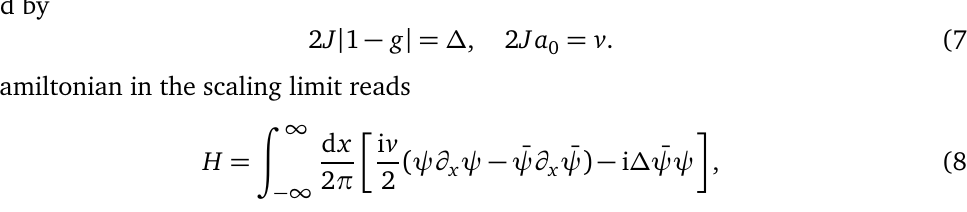
Figure 11: Left: Rate function of the return probability following linear quenches of different durations. We stress that the first critical time t (cid:63) time axis we indicate the quench durations τ = 1 is crossed. Right: Scaling of the critical momenta defined via Re z point g c = 1 / 2 for a linear quench. The behaviour is consistent with k (cid:63) ,˜ k ∝ τ − 1 / 2 n ˜ k